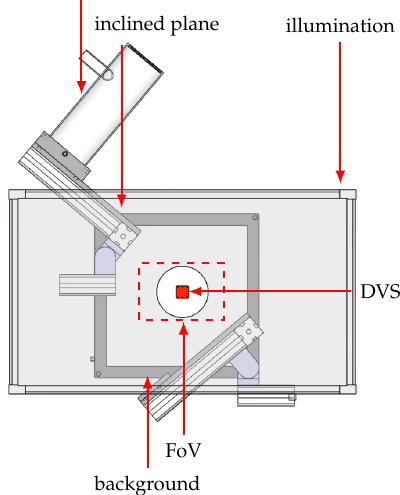
Figure 5. Experimental setup to generate the event-based ball dataset. The illumination panel is shown transparent for a better overview. Starting from the upper cylinder, the balls roll over an inclined plane and cross the camera’s FoV diagonally. As the balls are in free fall they rotate and the camera is able to perceive the object’s pattern in motion. In order to record a large amount of data the cycle is automated by pneumatic conveyance, returning the ball back to the starting point.